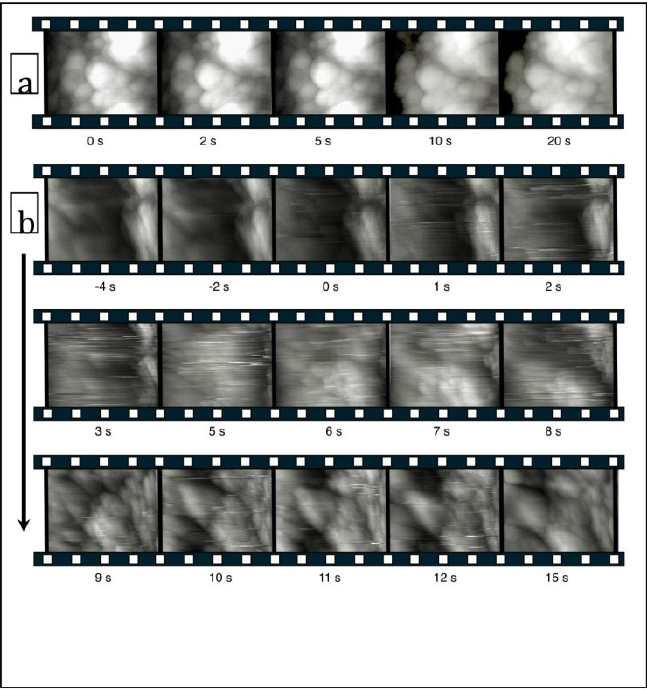
Figure 12. Frames (1.5 µm × 1.5 µm) taken from HS AFM movies of the surface of polished bovine enamel. Film strip ( a ) is a sequence of images record in water; the film strips in ( b ) show a sequence of images recorded before, during, and after the addition of citric acid at pH 3. The time of the addition of the acid is marked as 0 s. Reprinted with permission from [85]. Copyright 2009 International Society of Histology and